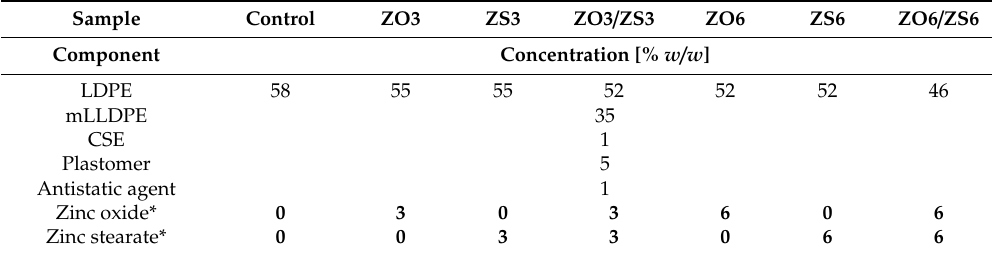
Table 1. Composition of PE films containing functional zinc